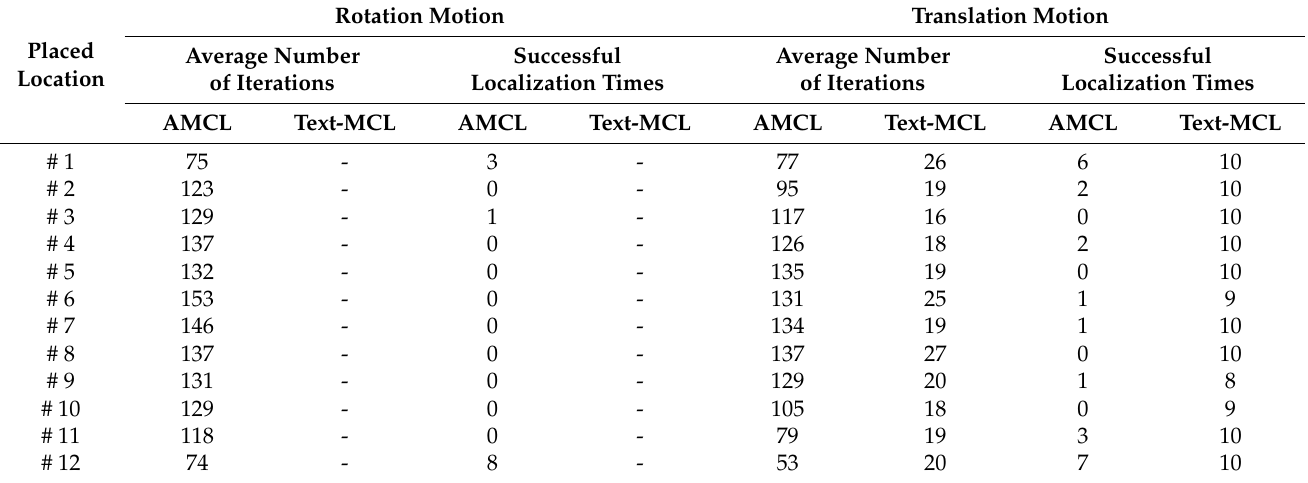
Table 2. Successful localization times and iterations when particles converged.